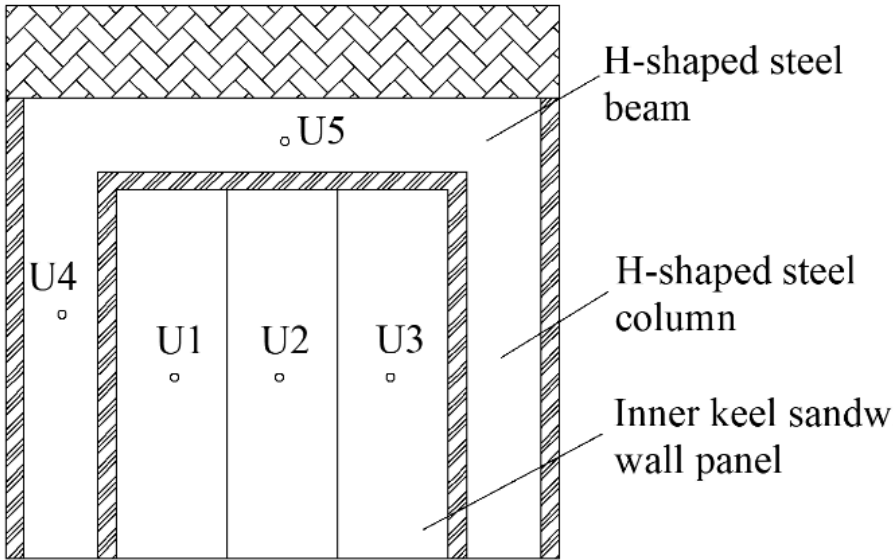
Figure 9. Layout of temperature measuring points in the fire resistance test of the integrated enclosure system.